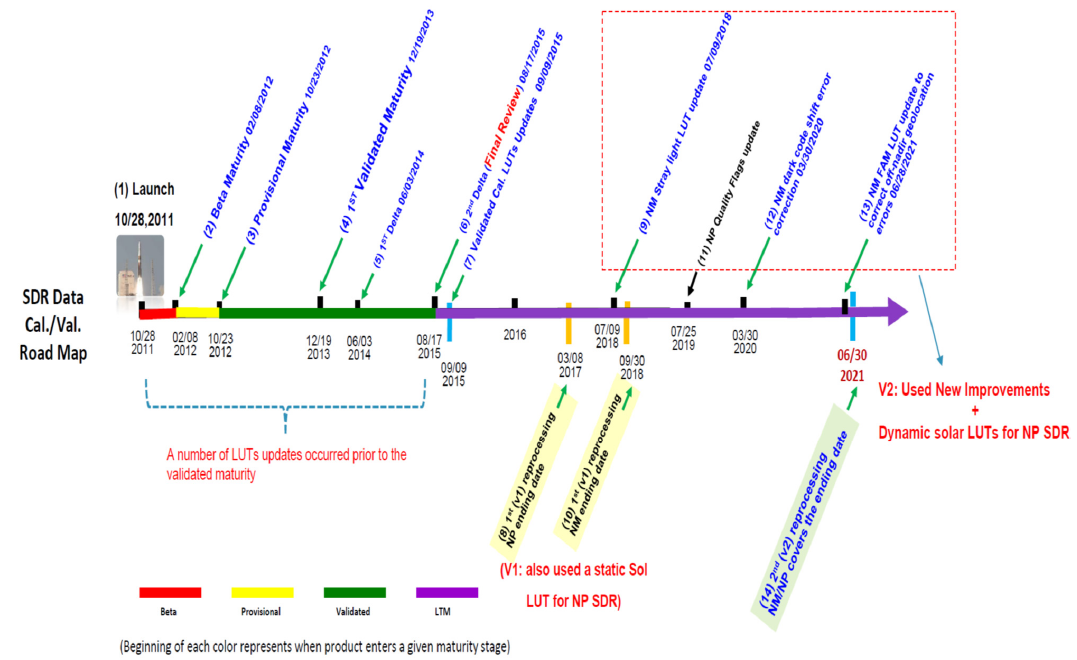
Figure 2. Timeline of official reviews required by the JPSS program and major improvements (up-